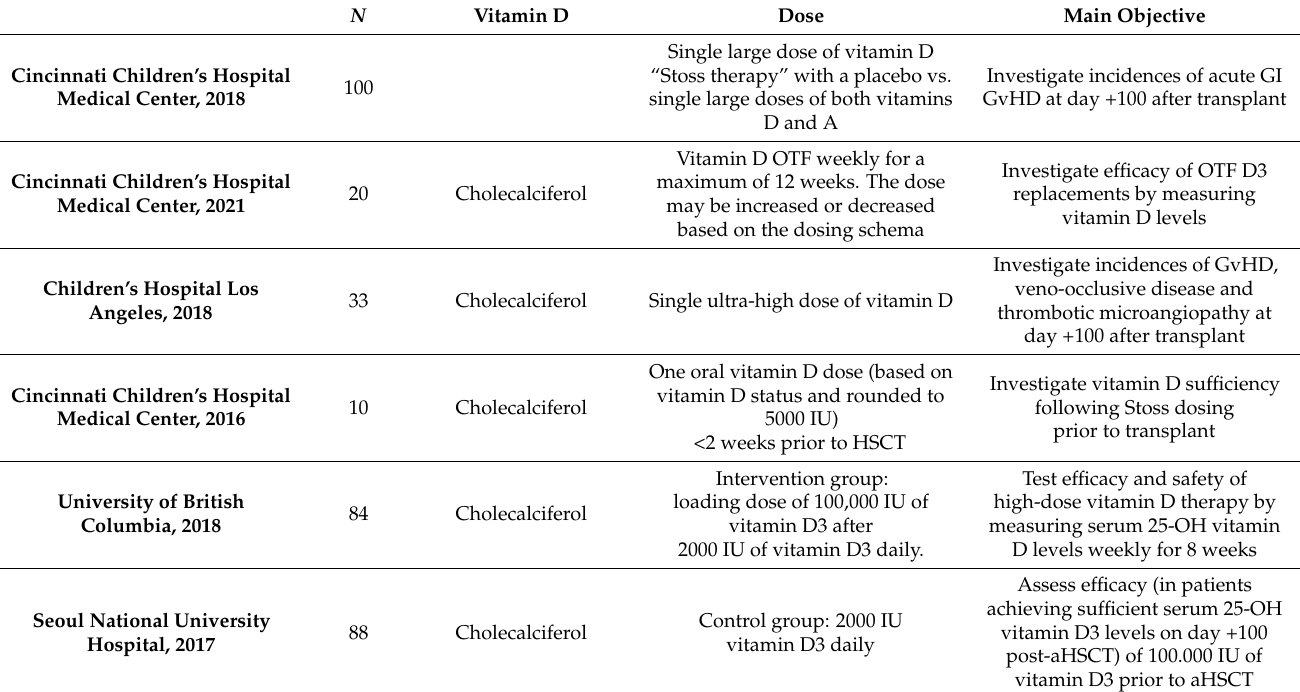
Table 4. Clinical trials currently active and evaluating the use of vitamin D among patients undergo- ing